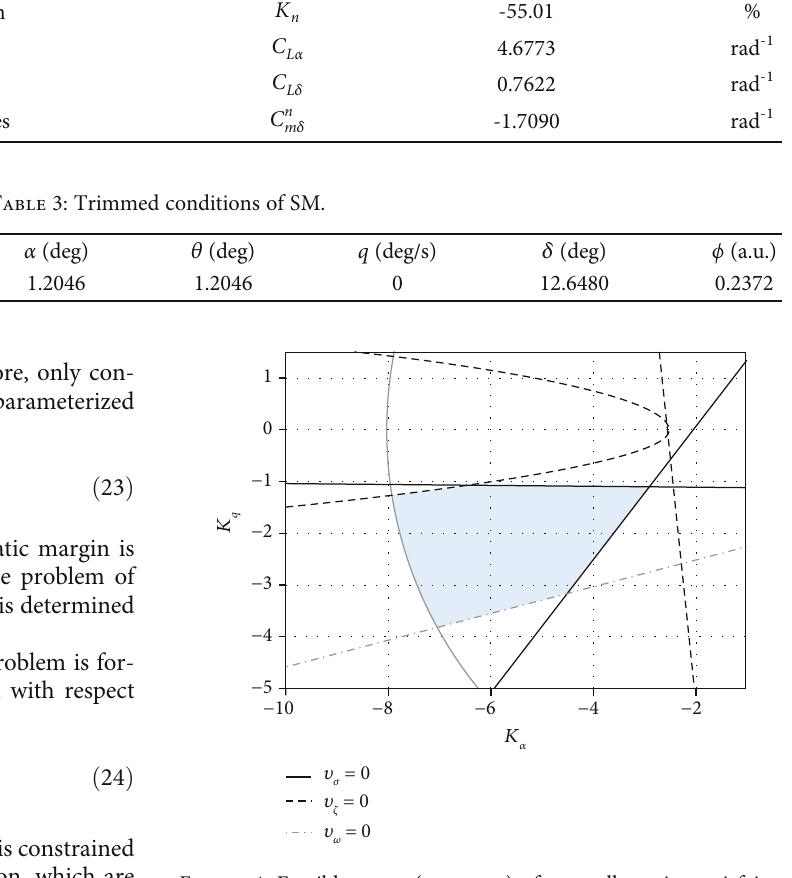
Figure 4: Feasible range (gray area) of controller gains satisfying input saturation (solid gray line) and FQ